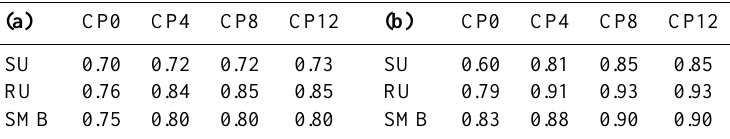
Table 4. (a) Skill scores related to the annual anomalies over the 1990–2010 period between the 15km resolution MAR outputs (15rt) and the 25km resolution (25rt) sublimation and evaporation (SU), run-off of meltwater (RU) and GrIS SMB from the MAR model, without correction (CP0), and corrected with daily gradients implemented on each grid point from the four (CP4), eight (CP8) and twelve (CP12) closest points at 25km resolution. (b) The same as (a) , but between the 25rt and 25st outputs. (a) CP0 CP4 CP8 CP12 (b) CP0